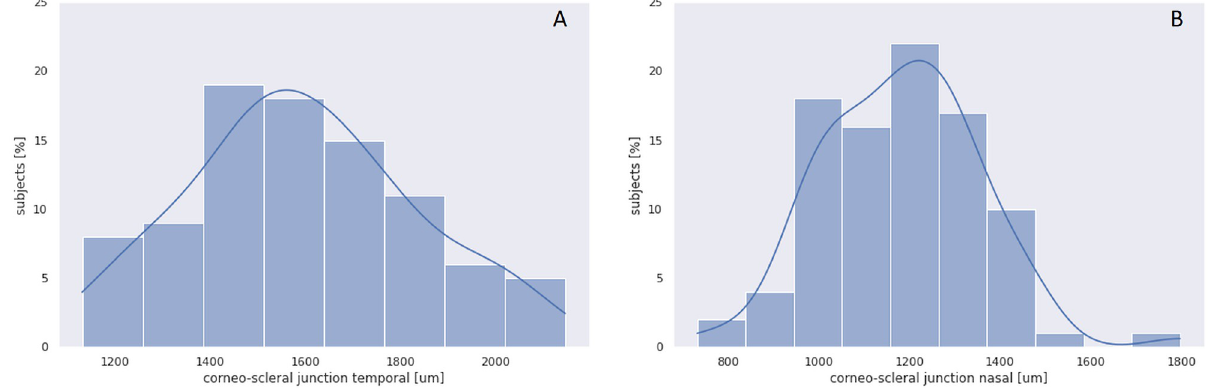
Fig 3. A, B. Frequency distribution of the corneo-scleral junction width. (A) temporal (B) nasal.